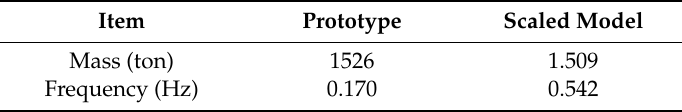
Table 2. Mass and frequency of the scale bridge model.